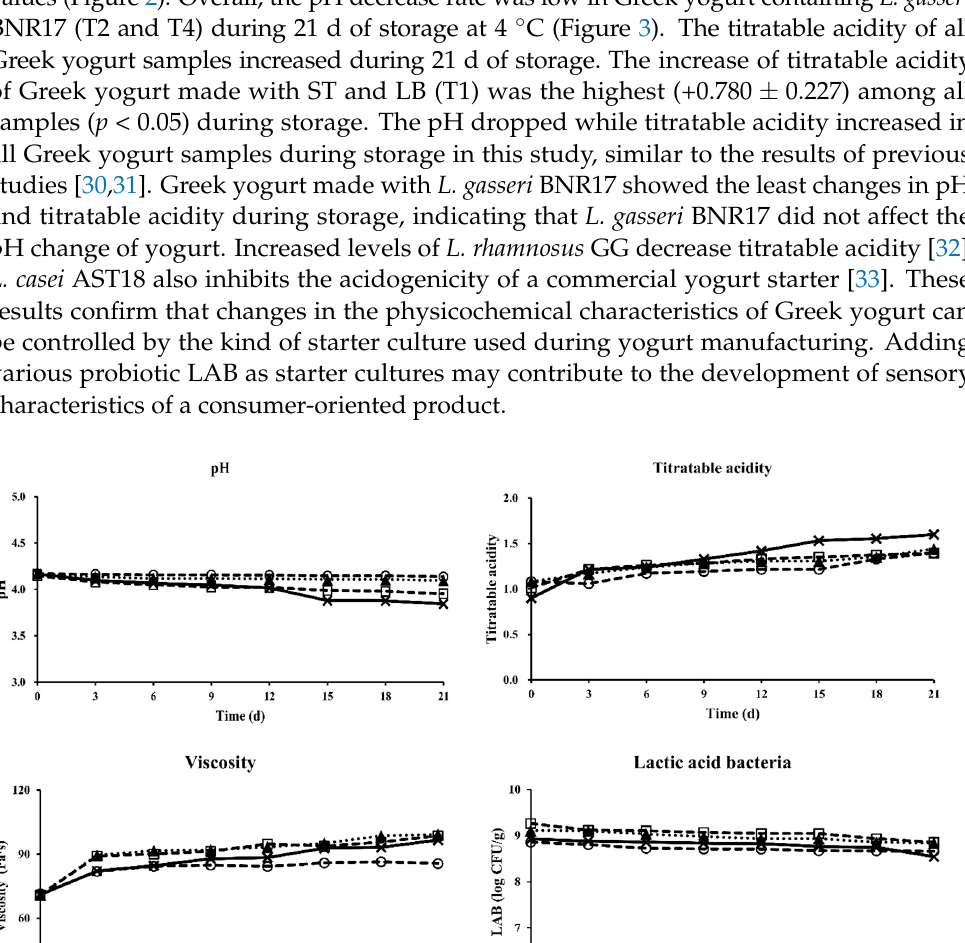
( A ) ( B ) Figure 3. Increase rate of titratable acidity and viscosity ( A ), and decrease rate of pH and LAB ( B ). Decrease rate = (final value − initial value)/initial value, Increase rate = (final value − initial value)/in- itial value. T1: S. thermophilus and L. bulgaricus ; T2: S. thermophilus, L. bulgaricus and L. gasseri BNR17; T3: S. thermophilus, L. bulgaricus and L. plantarum HY7714; T4: S. thermophilus, L. bulgaricus, L. gasseri BNR17 and L. plantarum HY7714. A–D Means values in the TA and pH categories with different letters are significantly different ( p < 0.05) a–c Means values in the viscosity and LAB categories with differ- ent letters are significantly different ( p < 0.05). 3.2. Effect of Probiotic LAB on Viscosity and LAB Population Consumers favor Greek yogurt because of its unique firmness, dense texture, mod- erate sweet aromatic, milk fat and dairy sour flavors, and moderately sour taste [23]. Thus, viscosity is one of the most important quality characteristics of Greek yogurt. In the pre- sent study, the viscosity of Greek yogurt ranged from 70.9 to 71.4 Pa·s (7.09 × 10 4 to 7.14 × 10 4 mPa·s) at 0 d after centrifugation. It was increased during 21 d of storage at 4 °C (Figure 2). Greek yogurt containing L. plantarum HY 7714 (T3 and T4) had the highest viscosity at 21 d and the highest increase rate of viscosity during 21 d of storage among samples (Fig- ure 3) ( p < 0.05). L. plantarum strains can produce exopolysaccharide (EPS), a macromole- cule composed of monosaccharide residues of sugar and sugar derivatives. EPS can act as